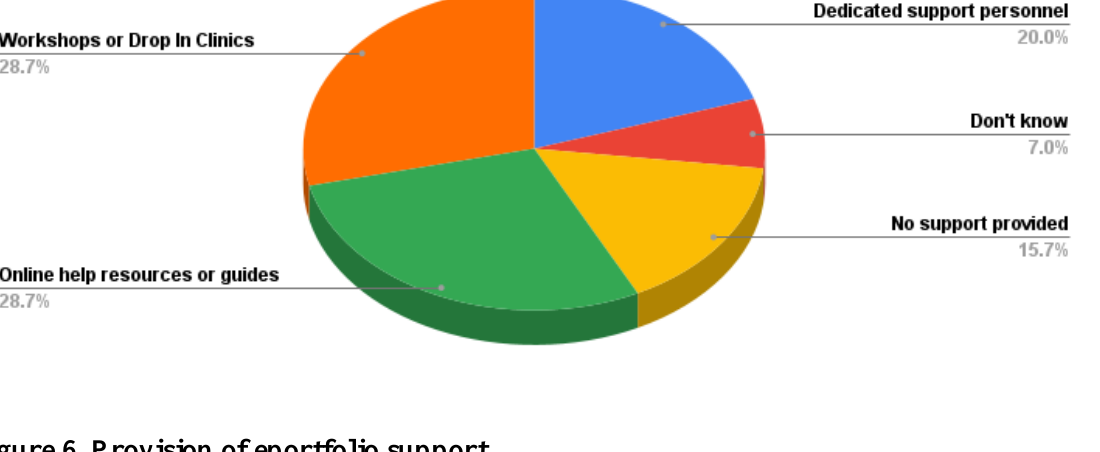
Figure 6. Provision of eportfolio support